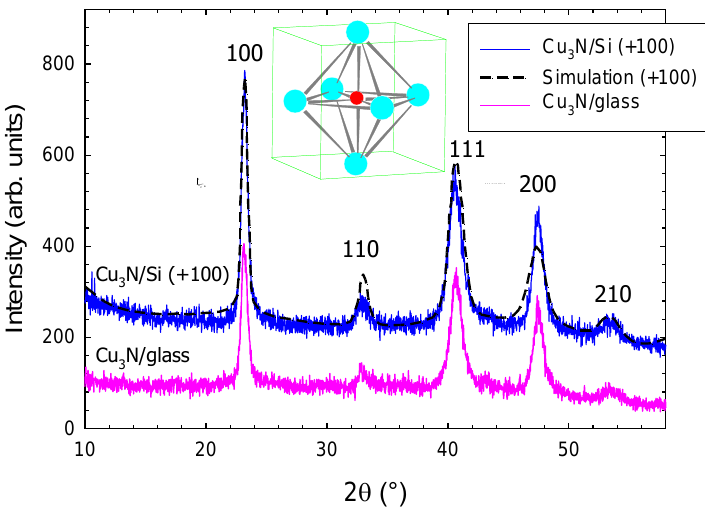
Figure 4. Measured and simulated (solid line) X-ray diffraction pattern of polycrystalline Cu 3 N films deposited on a Si and on a glass substrate. Simulation results (dashed line) are also shown for the Cu 3 N/Si data. To ease comparison, the Cu 3 N/Si data spectra have been shifted upwards by +100.